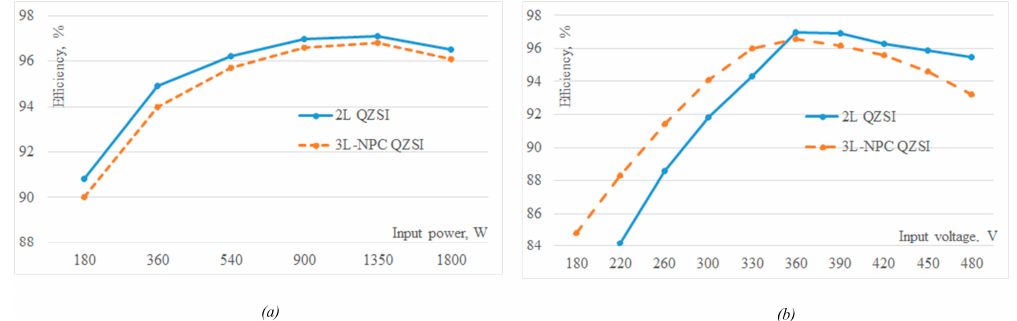
Figure 8. Grid-connected operation of 3L NPC QZSI at a nominal power level of 1800 W ( a ) and in boost voltage mode at a reduced power level of 900 W ( b ).